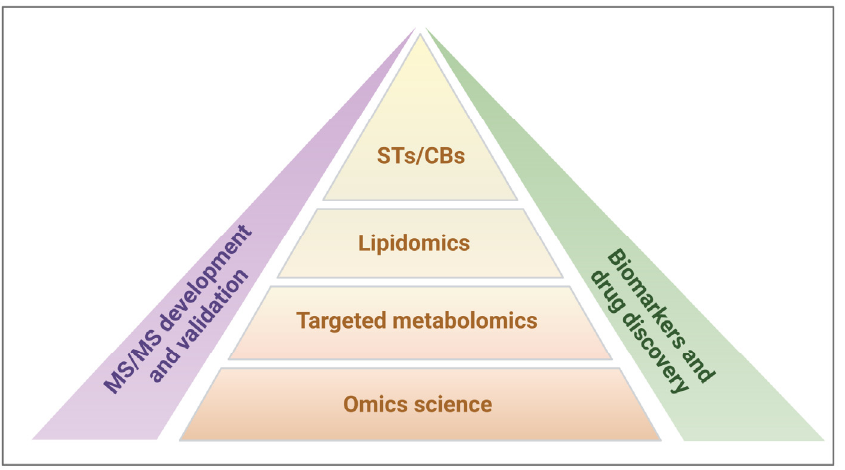
Figure 1. Schematic representation of our analytical research strategy to assess the cross-functional interplay between steroid and cannabinoid systems. Among the omics research topics, our targeted metabolomics approach focuses on lipidomics, specifically on steroids (STs) and cannabinoids (CBs). Our studies benefit from advances in the development and validation of tandem mass spectrometry (MS/MS) methods to provide new insights into biomarkers and drug discovery.